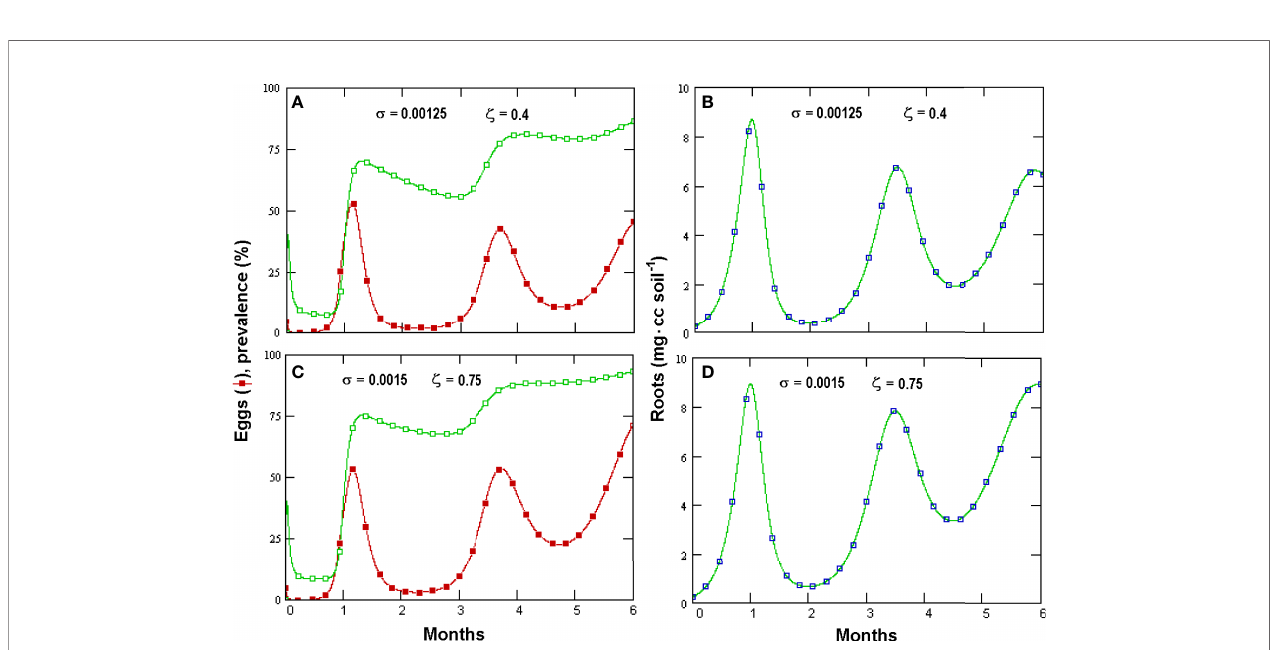
FIGURE 5 | Effects of increasing Pochonia chlamydosporia non-parasitic growth rate ( s , insets) and propagules switch to parasitism ( z ) on prevalence (empty squares) and Meloidogyne incognita egg densities ( fi lled symbols) (A , C) and root density (B , D) as simulated by GPNRd (for initial variables see Table 1